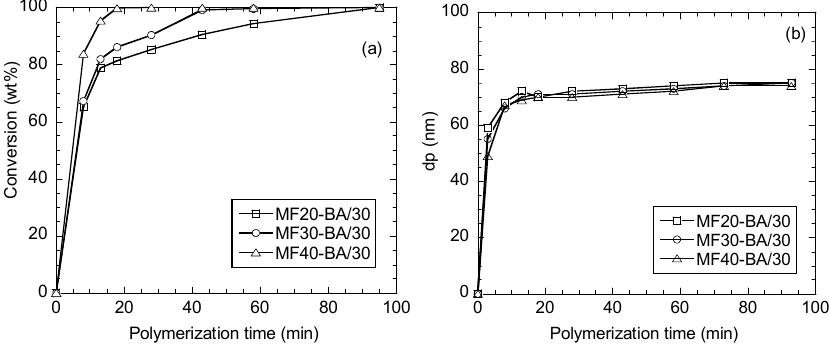
Figure 4. Methacrylate fructose-based copolymers. ( a ) Kinetics and ( b ) particle size evolution for copolymerizations carried out with 0.5 wbm% of KPS.